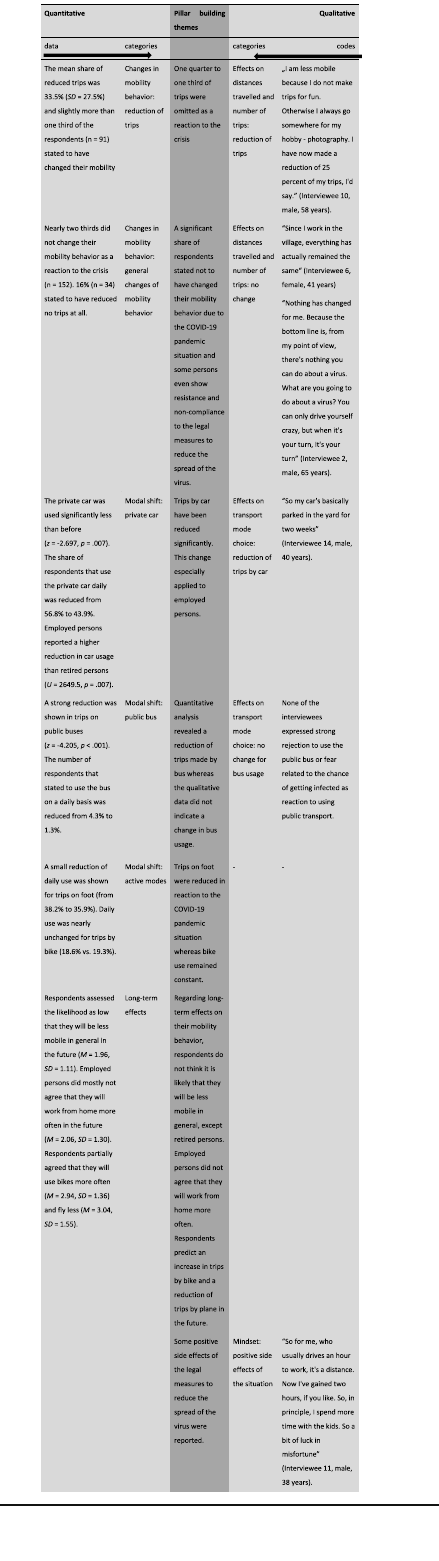
Table 3 Joint Display of qualitative and quantitative